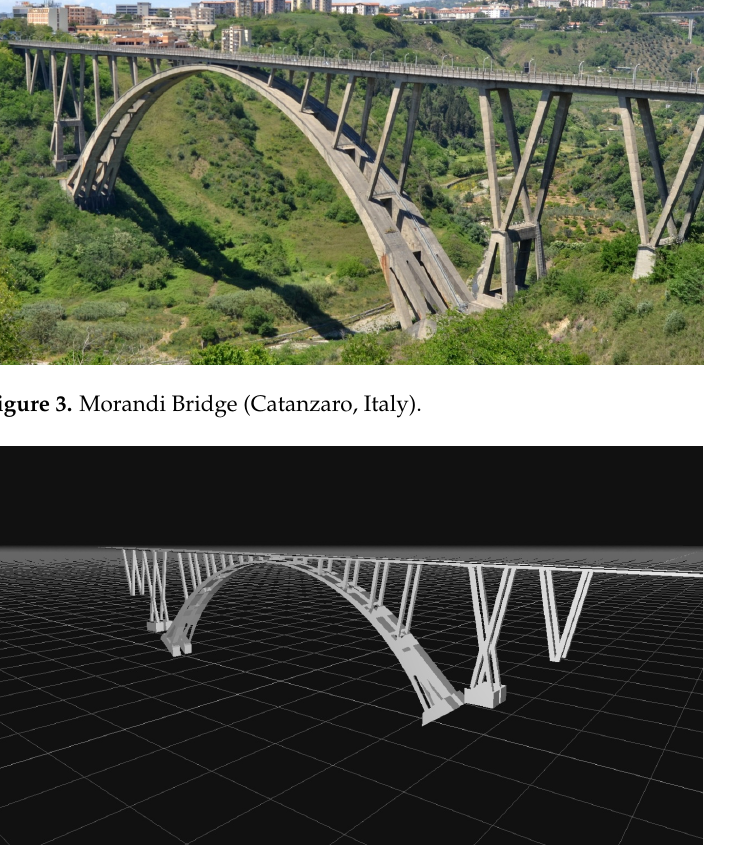
Figure 4. Morandi Bridge (Catanzaro, Italy) digital twin creation.